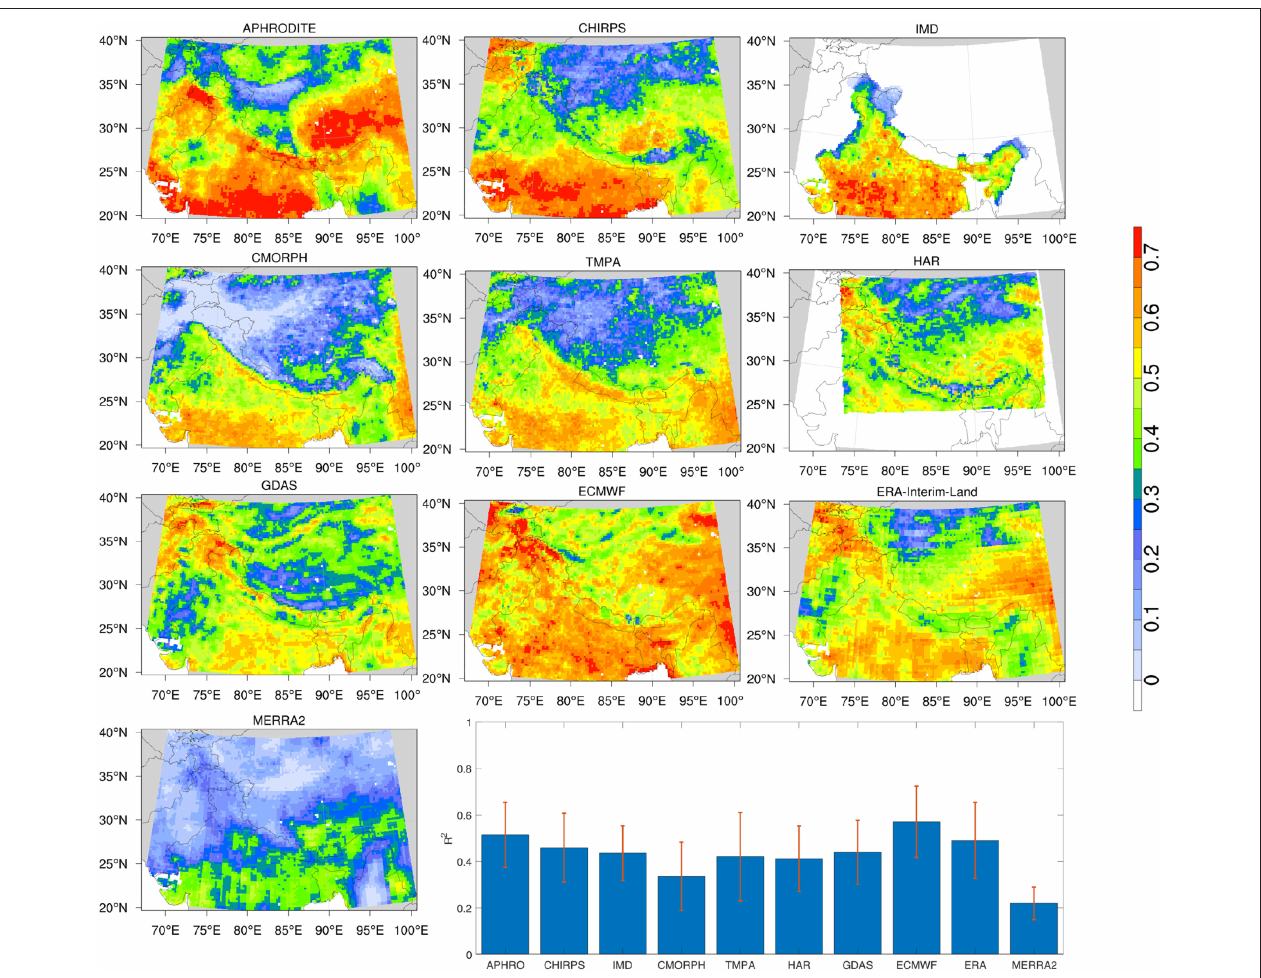
FIGURE 7 | Same as Figure 6 , but for r 2